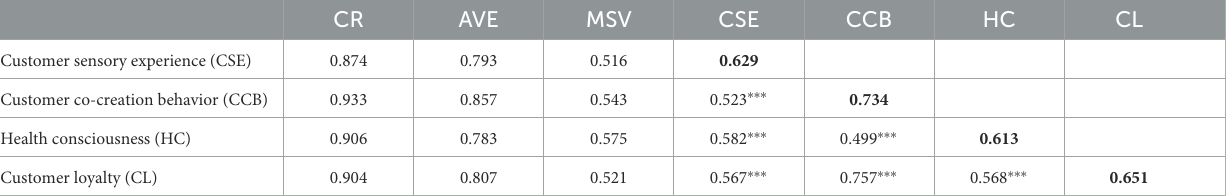
TABLE 2 Results of the discriminant validity test ( n = 487).